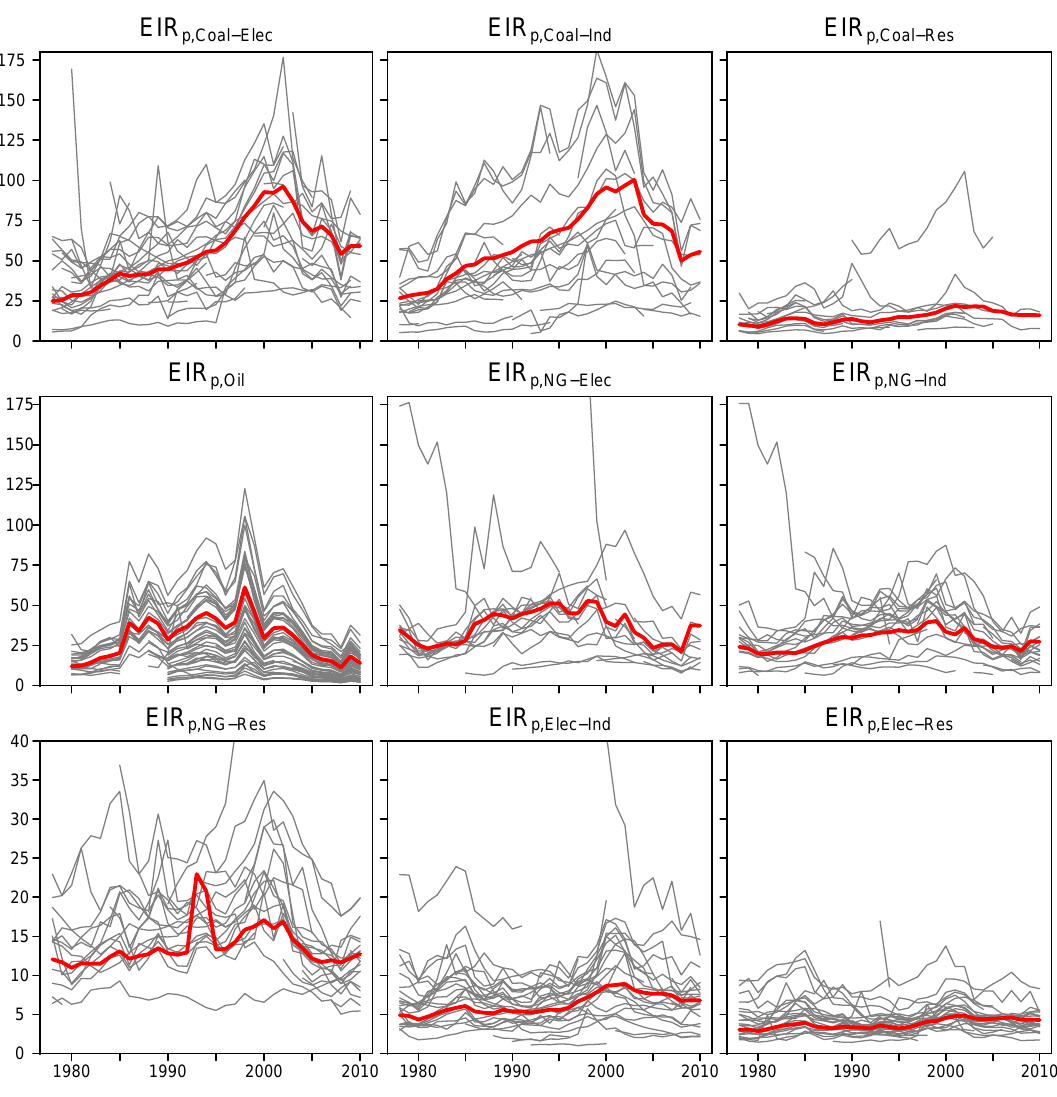
Figure 5. The individual price-based energy intensity ratios, EIR p , for all n = 9 energy n commodities considered in this paper show a general trend of increasing from the early 1980s through approximately 1998 followed by a decade-long decline through 2008 until the onset of the Great Recession. Thin gray lines represent individual country calculations, and the single thick red line is the GDP-weighted average of all EIR p each year. NG = natural gas, Elec = electricity, Ind = industrial, and n Res = residential, such that, for example, EIR p is the “EIR of the price of natural gas purchased NG,Res by the residential